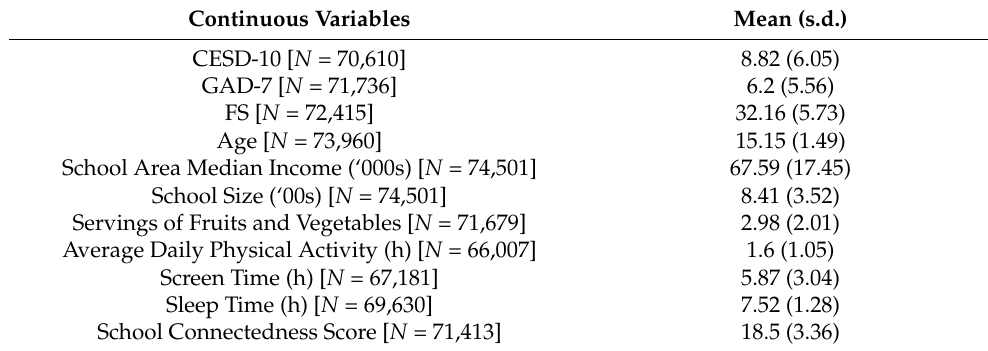
Table 1. Sample characteristics for students participating in Year 7 (2018–2019) of the COMPASS Study ( N =